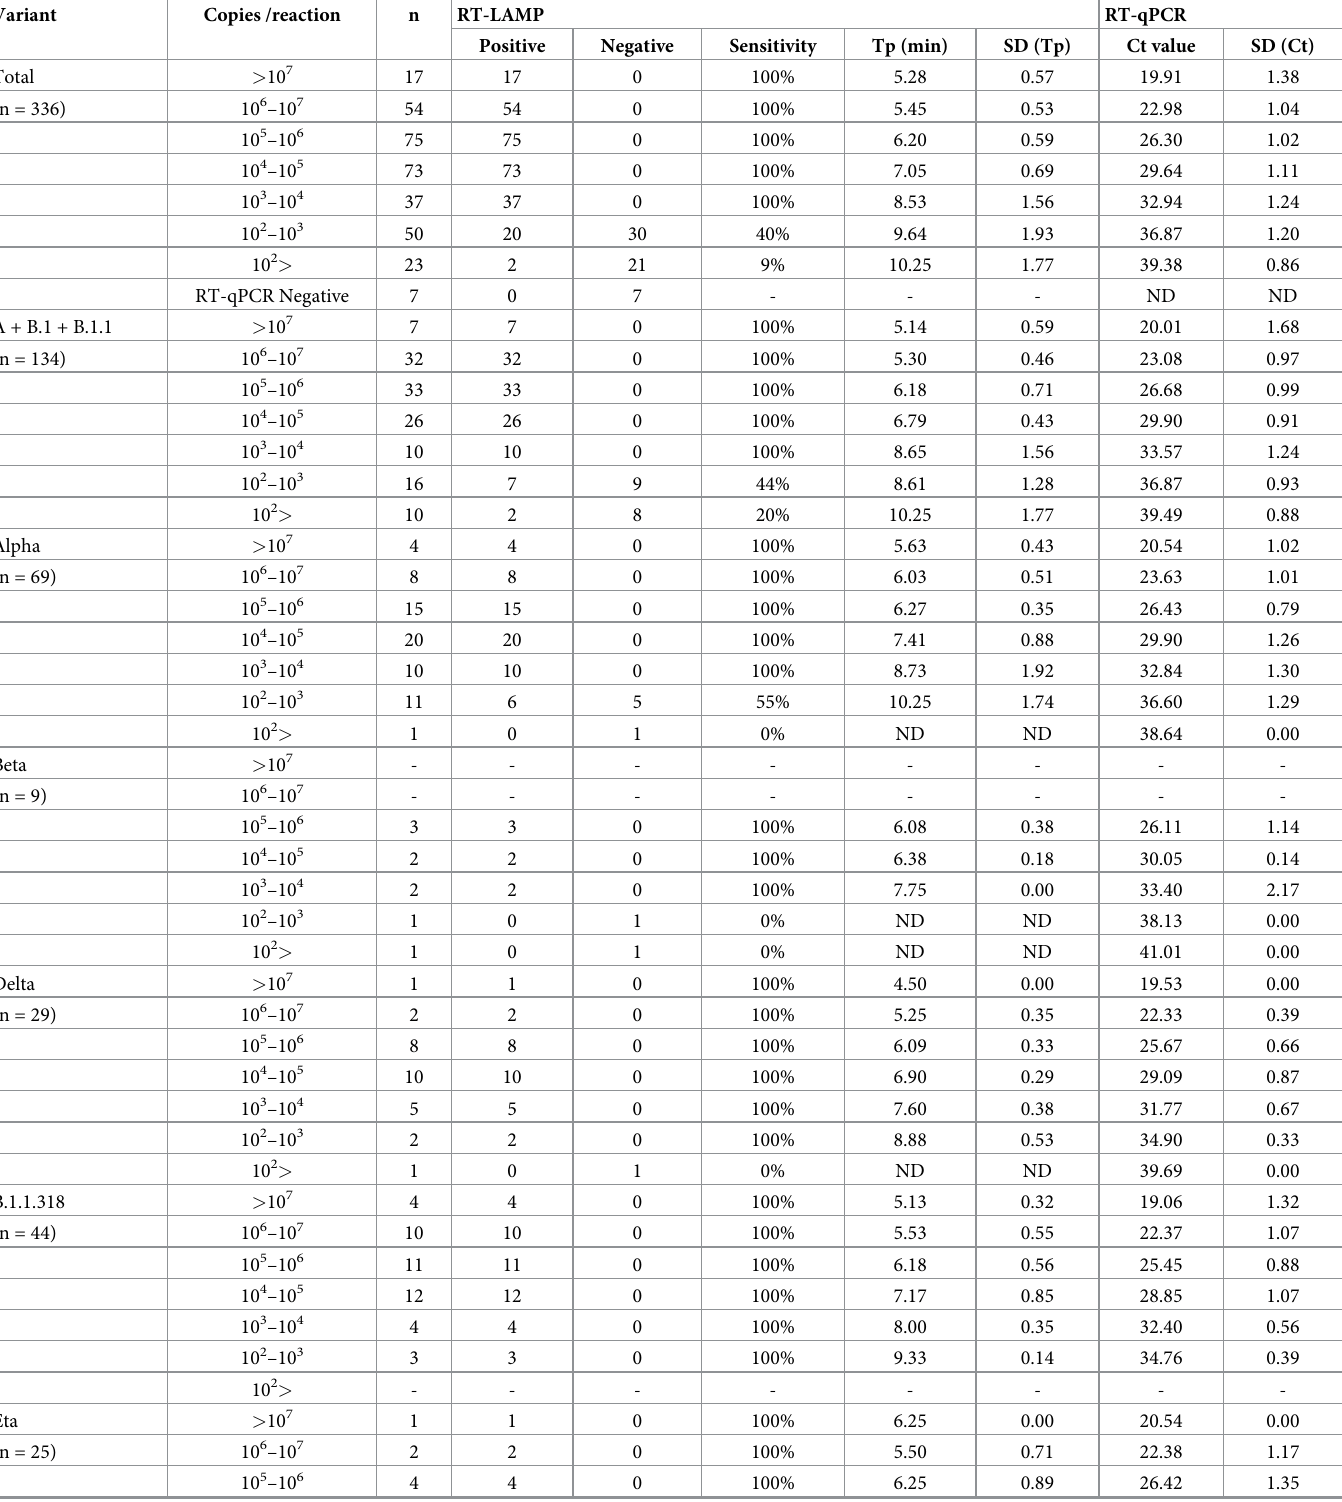
Table 3. Validation of RT-LAMP assay using clinical samples collected in Gabon.